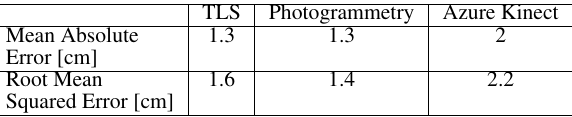
Table 2. DBH value for each individual trunk scanned.